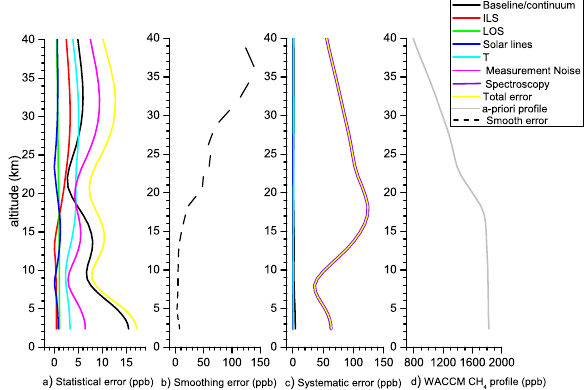
Fig. 3. Estimated errors for the profiling retrieval (PR): (a) statistical (random) errors of parameters listed in Table 2, (b) smoothing error, (c) systematic errors, and (d) climatologic CH 4 profile simulated by the WACCM model that is used as the a-priori profile. The different colours are for the different uncertainty sources as explained in the legend. The yellow line represents the total errors, and the grey line is the WACCM